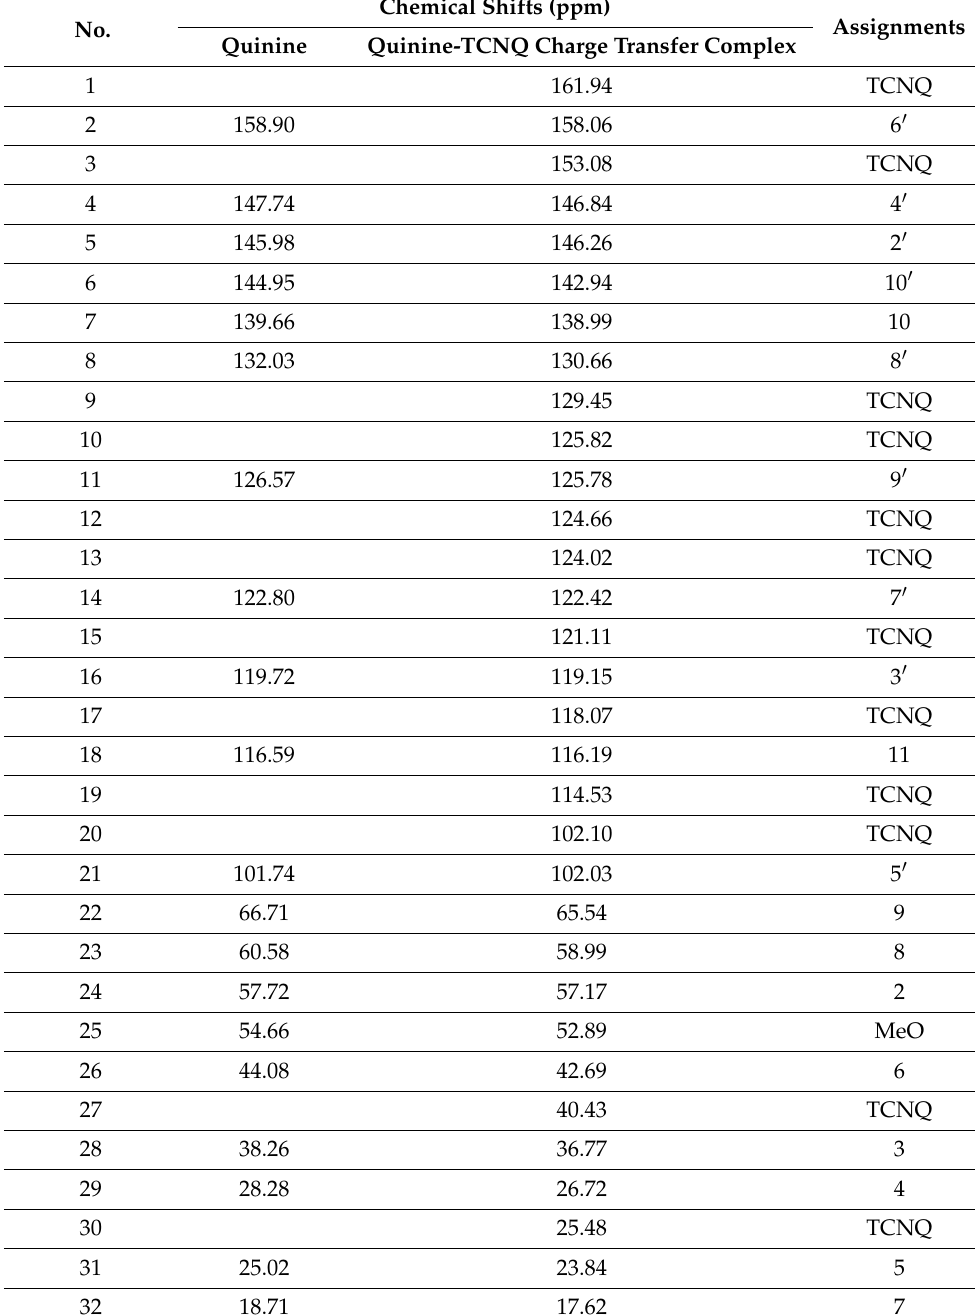
Table 5. 13 C chemical shifts in ppm for quinine and quinine-TCNQ charge transfer